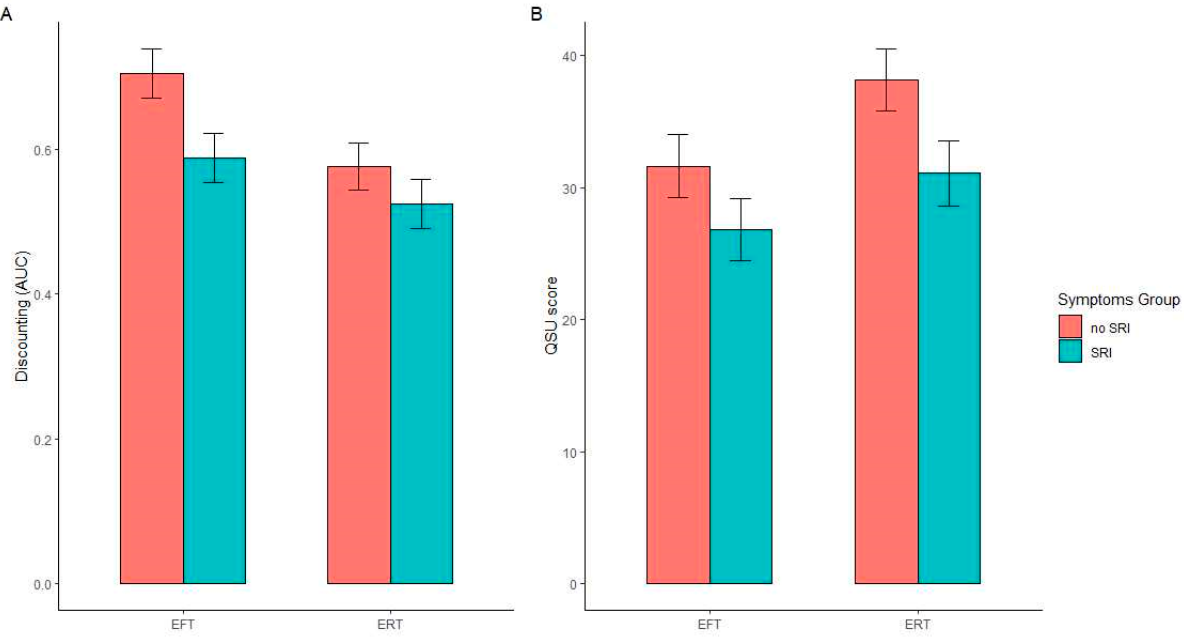
Figure 1. Mean covariate-adjusted values of delay discounting area under the curve (AUC; panel ( A )) and cigarette craving in the Questionnaire on Smoking Urges-Brief (QSU; (panel ( B )) in episodic future thinking (EFT) and smoking-related illness (SRI) groups. Higher values of AUC reflect less discounting of the delayed reward. Higher values of QSU score reflect greater cigarette craving. Error bars represent standard error of the mean. Significant main effects of EFT and SRI were observed on both measures (in both cases, p < 0.050), with no significant EFT × SRT interactions (in both cases, p > 0 . 330).